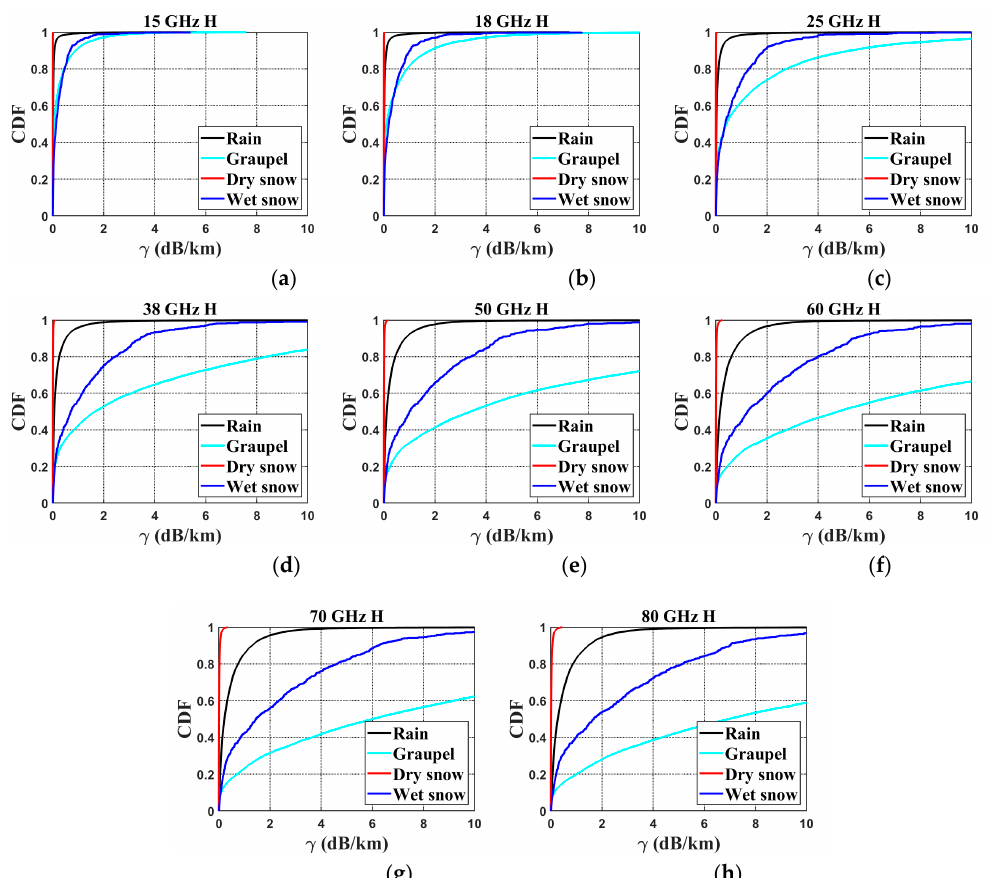
Figure 3. Cumulative distribution functions (CDFs) of horizontal-polarization attenuation rates induced by hydrometeors with frequencies of ( a ) 15 GHz, ( b ) 18 GHz, and ( c ) 25 GHz, ( d ) 38 GHz, ( e ) 50 GHz, ( f ) 60 GHz, ( g ) 70 GHz, and ( h ) 80 GHz for rain (black), graupel (cyan), wet snow (red), and dry snow (blue).